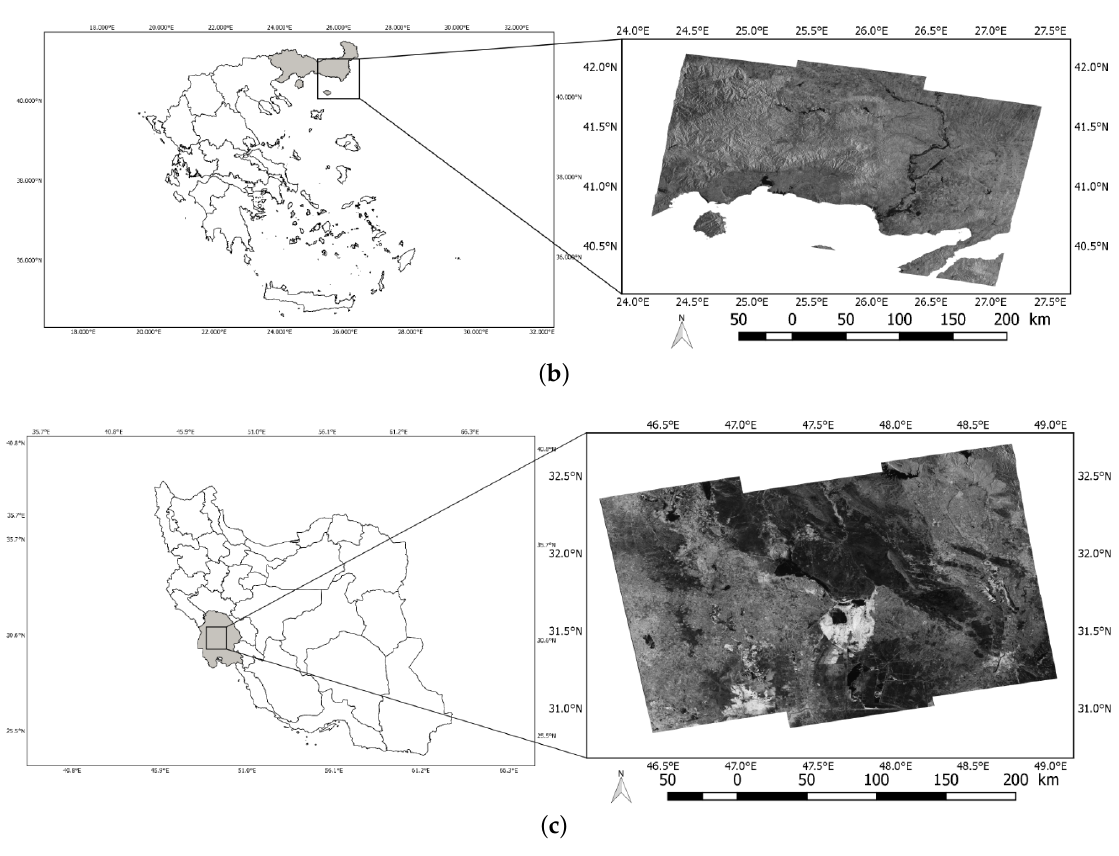
Figure 1. Study areas. ( a ) Site 1: Richelieu River, Quebec, Canada; ( b ) Site 2: Evros River, Evros, Greece; ( c ) Site 3: Dez River, Khuzestan,